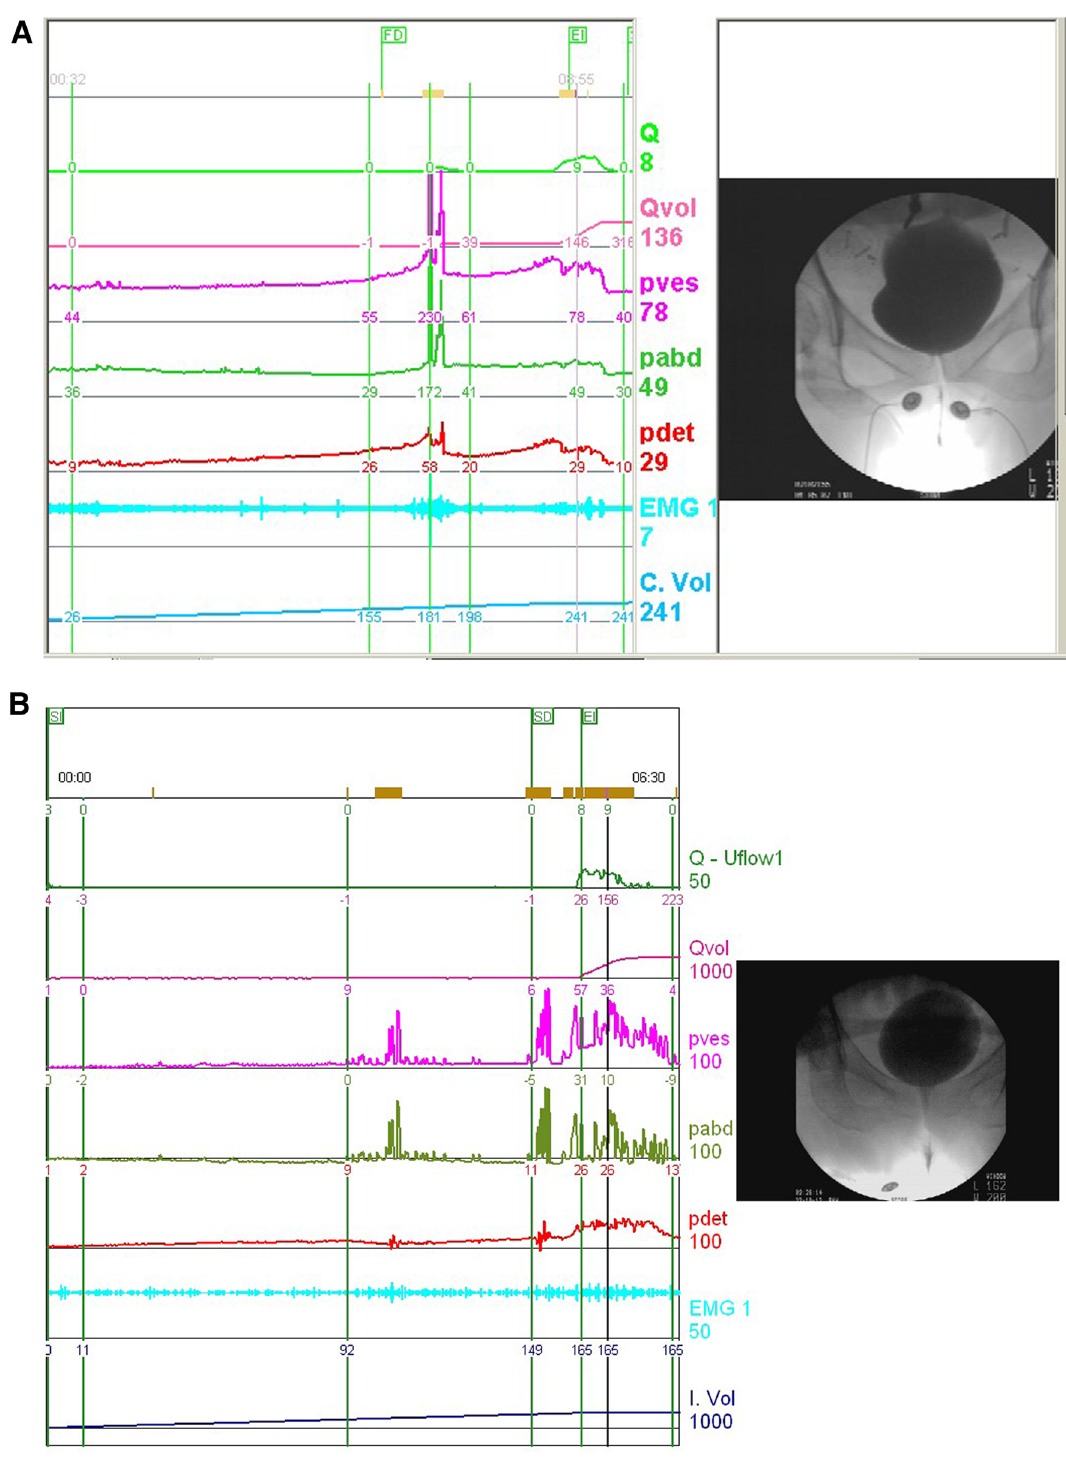
Figure 1. ( A ) Detrusor underactivity in a woman with bladder neck obstruction. The bladder neck was not widely open during the urination attempt. After receiving transurethral incision of the bladder neck, she resumed spontaneous voiding. ( B ) Detrusor underactivity in a woman without bladder outlet obstruction. The patient used abdominal pressure to aid spontaneous